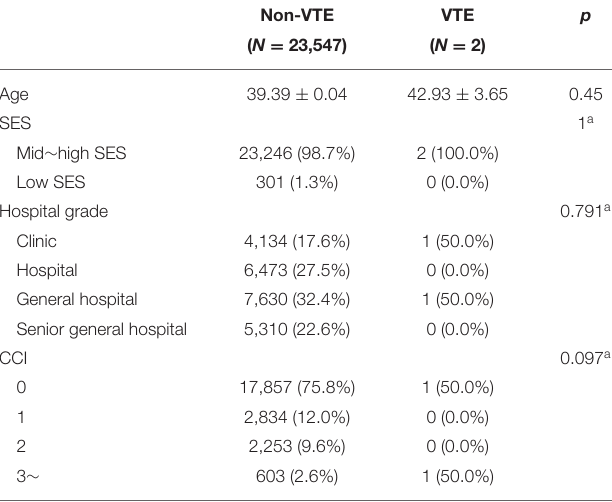
TABLE 2 | Characteristics of myomectomy in HIRA-NPS 2009-2018. TABLE 3 | VTE according to age per 5 years or death in myomectomy patients (HIRA-NPS